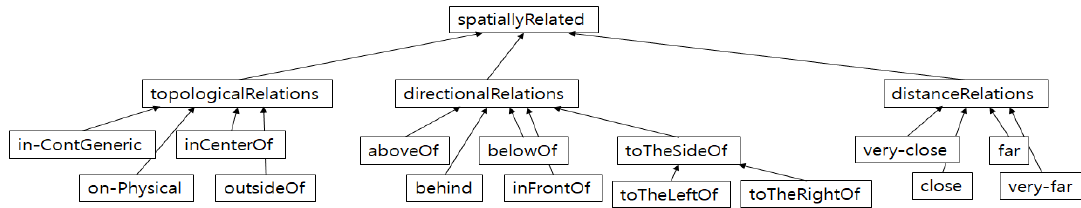
Figure 4. Properties of 3D spatial relation.